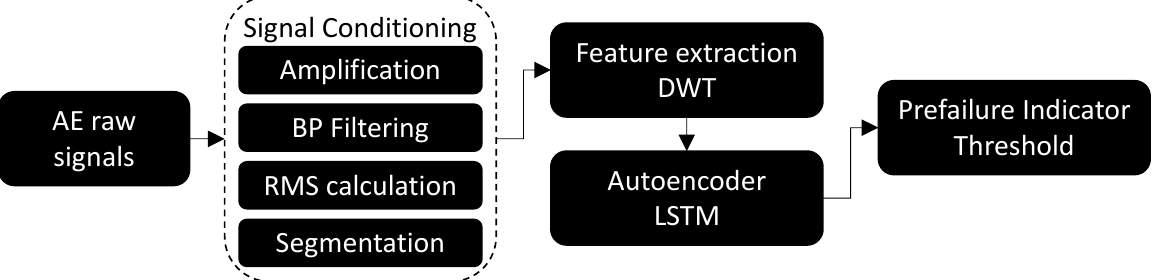
Figure 1. Anomaly detection approach flow chart.